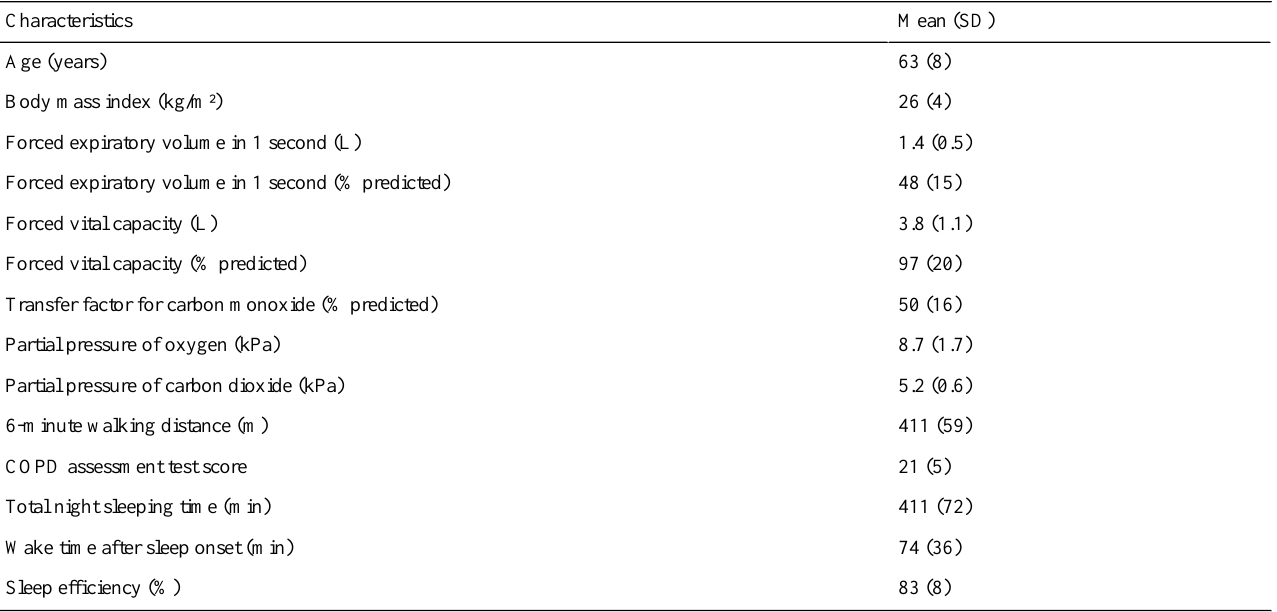
Table 1. Characteristics of the 20 included patients with moderate-to-very severe COPD a